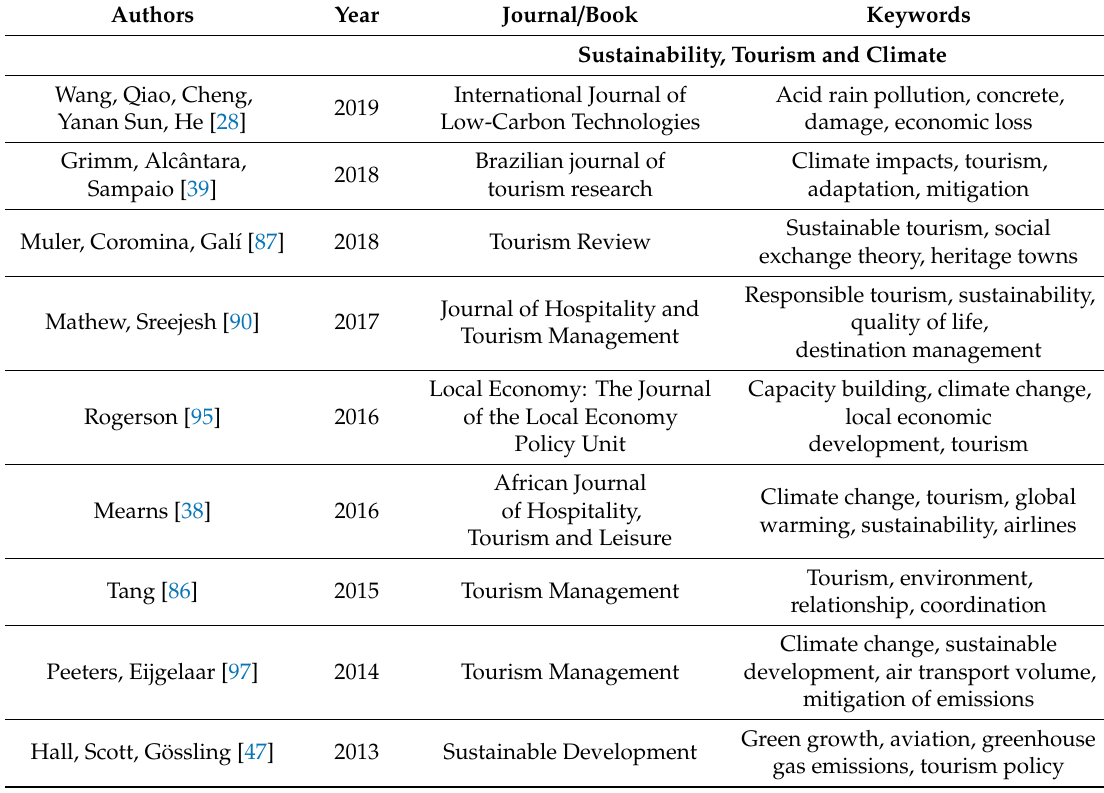
Table 3. Description of the literature on tourism, climate change, and